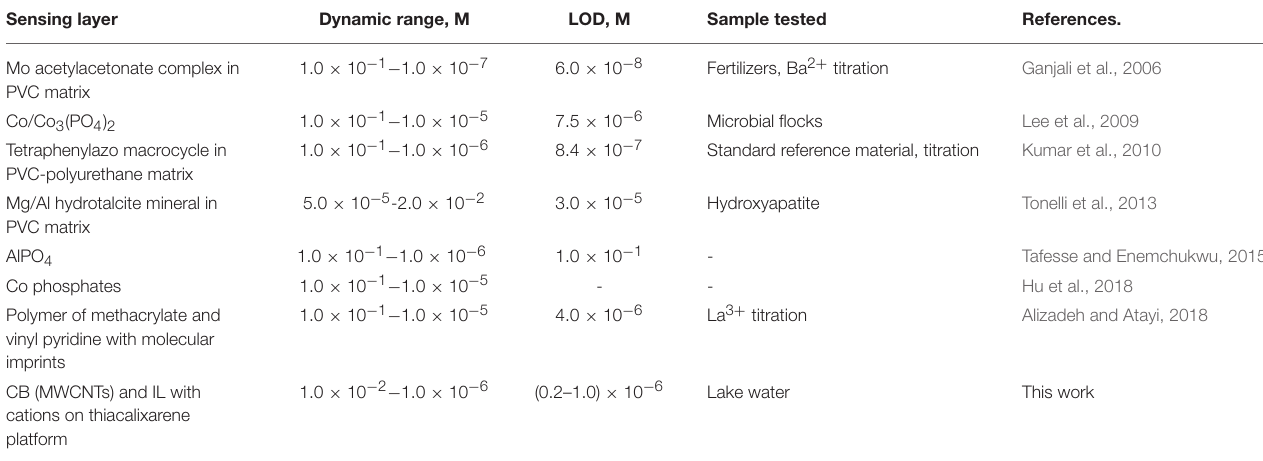
TABLE 3 | Comparison of the analytical characteristics of HPO 2 − 4 ions determination with potentiometric sensors. Sensing